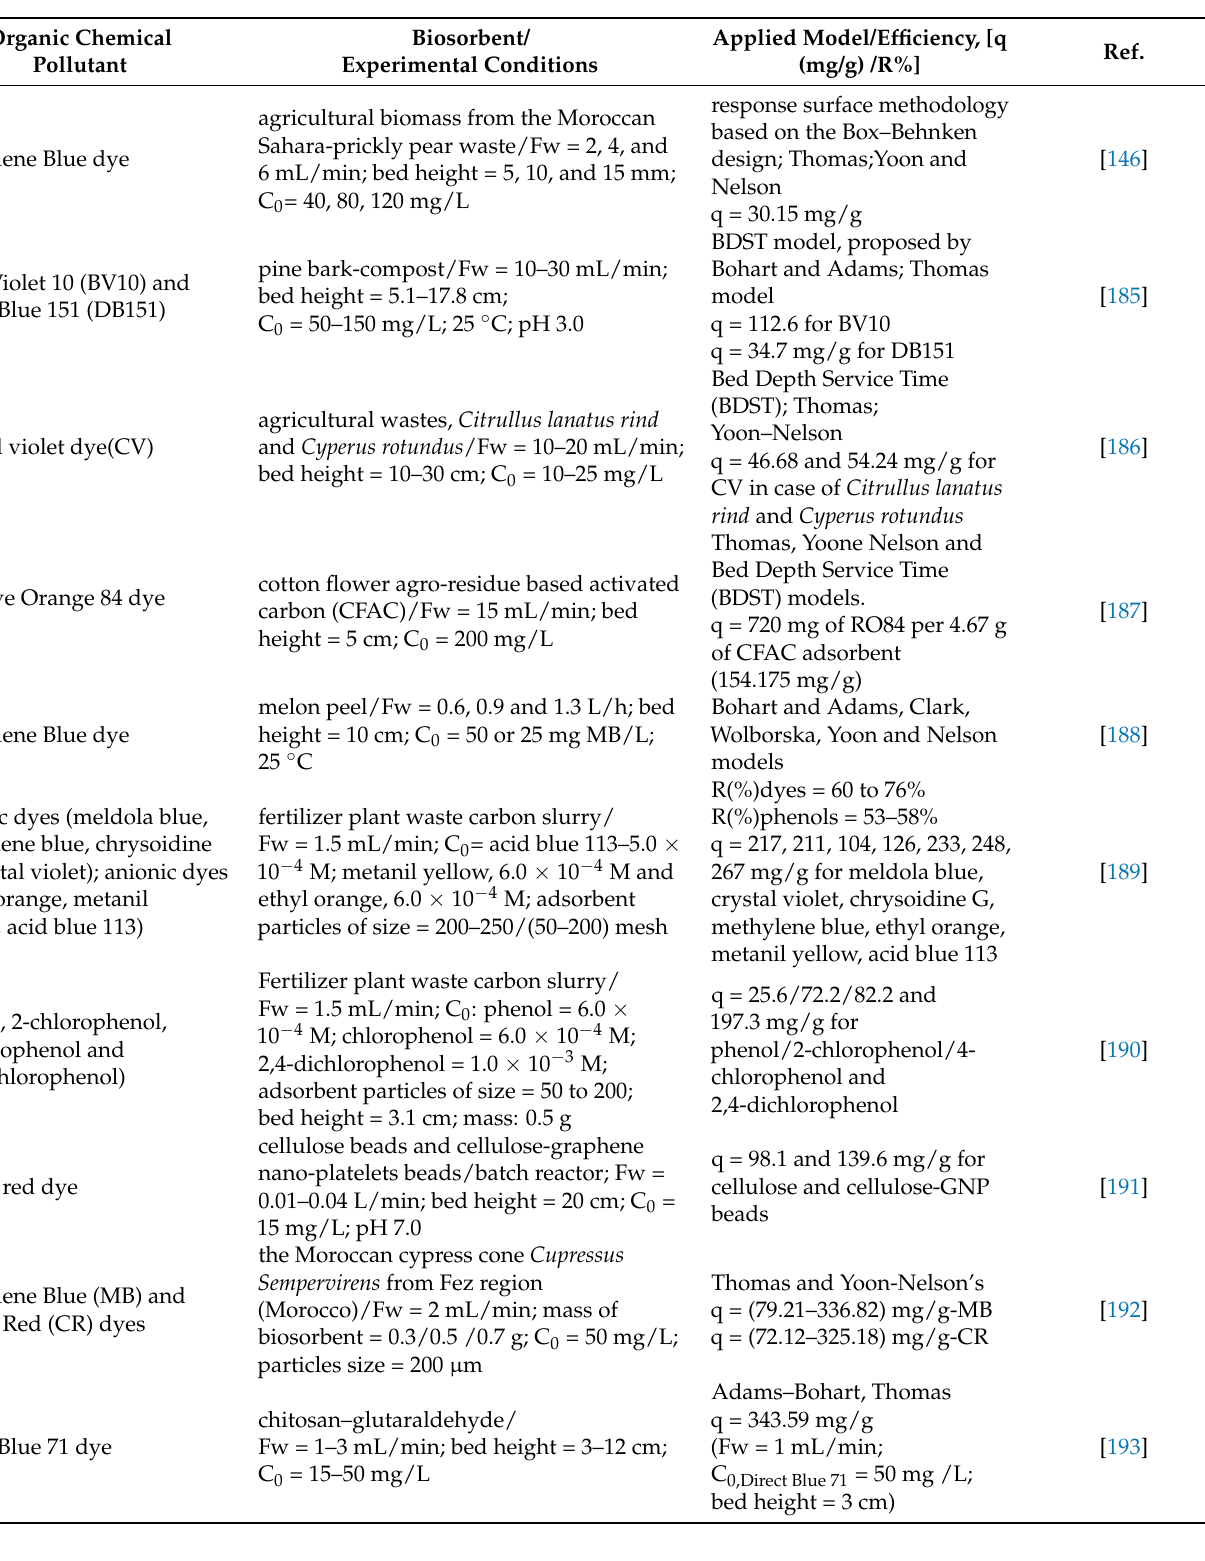
Table 4. Renewable resource biosorbents for dye removal from synthetic solutions by continuous biosorption